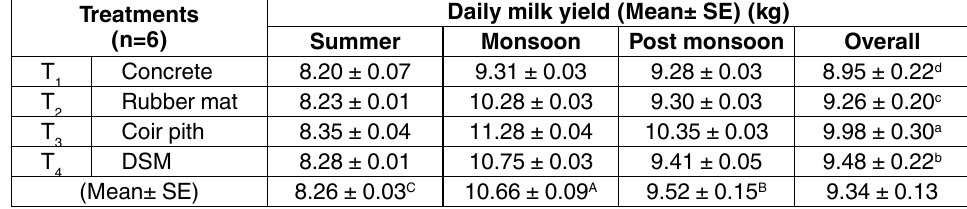
table 3. Mean daily milk yield in different bedding systems during different seasons treatments